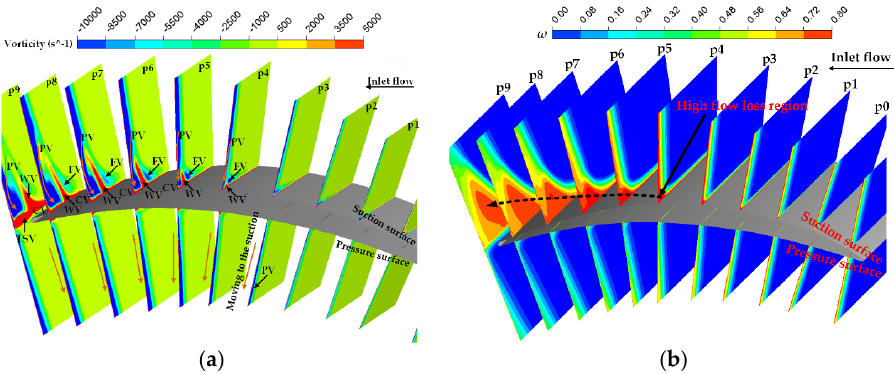
Figure 5. Flow structures within the high-speed compressor cascade corner separation and the development of the corresponding flow loss at an incidence angle of 0°. ( a ) Flow structures. ( b ) The development of flow loss.